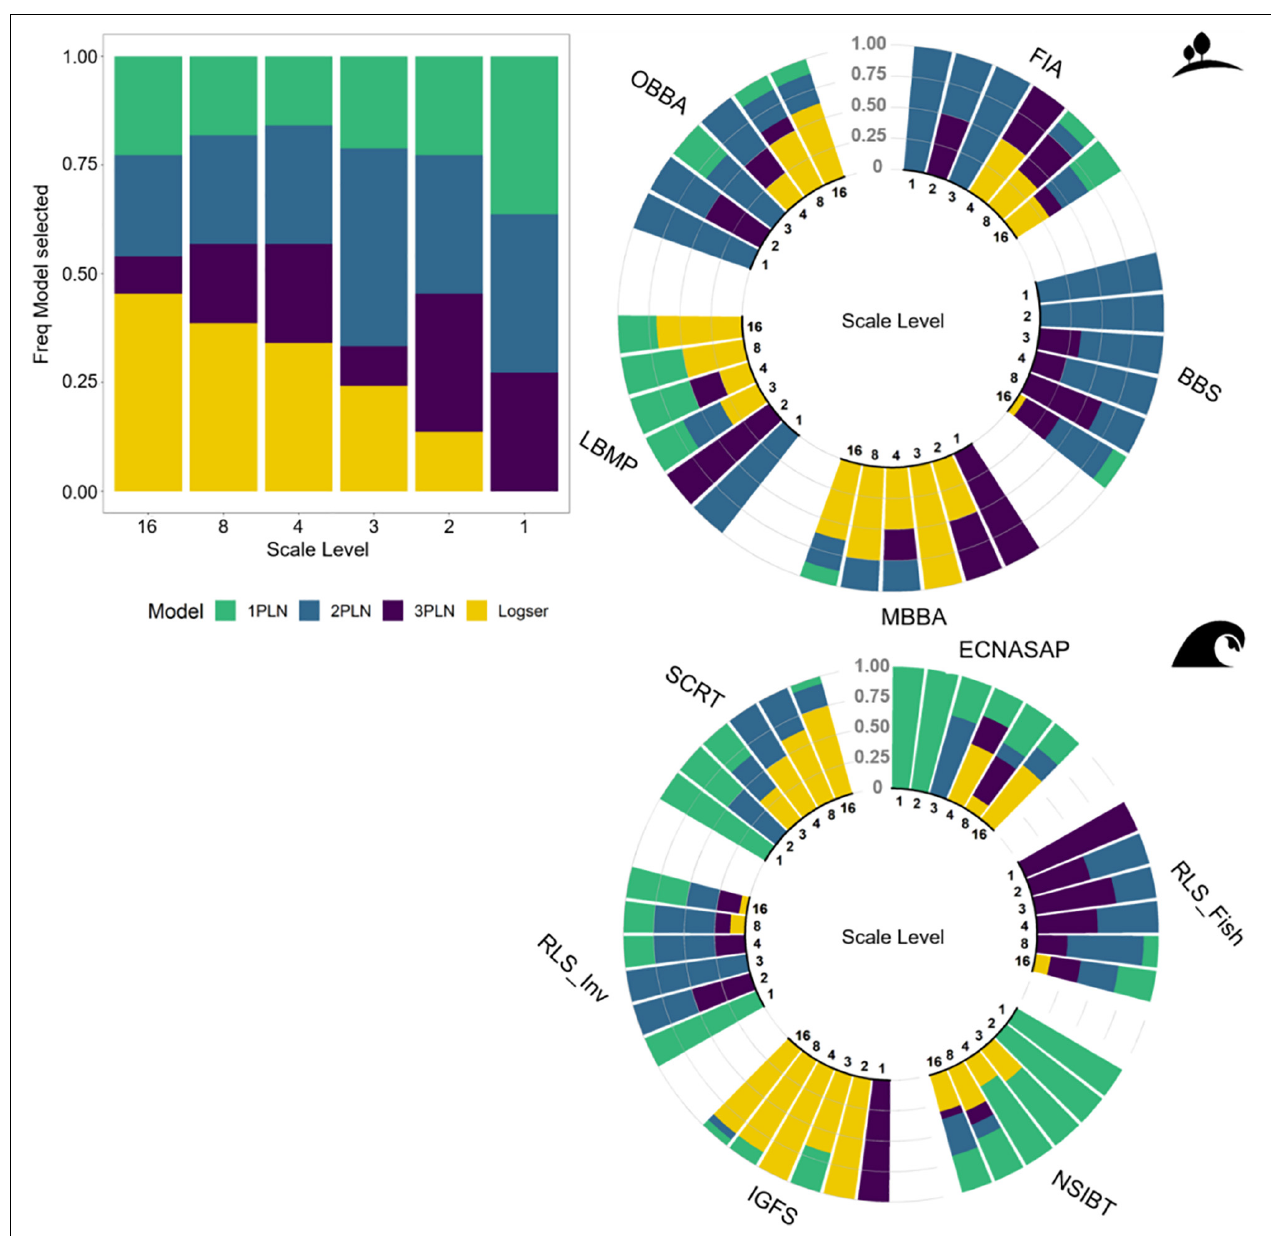
FIGURE 2 | Effect of the sampling level on SAD shape across the scale gradient, showing the aggregated pattern across all the communities (barplot) and for each individual community in the circular plots for terrestrial (top) and marine (bottom) datasets. The colors represent the best model selected by AICc, i.e., either 1PLN, 2PLN, 3PLN, or